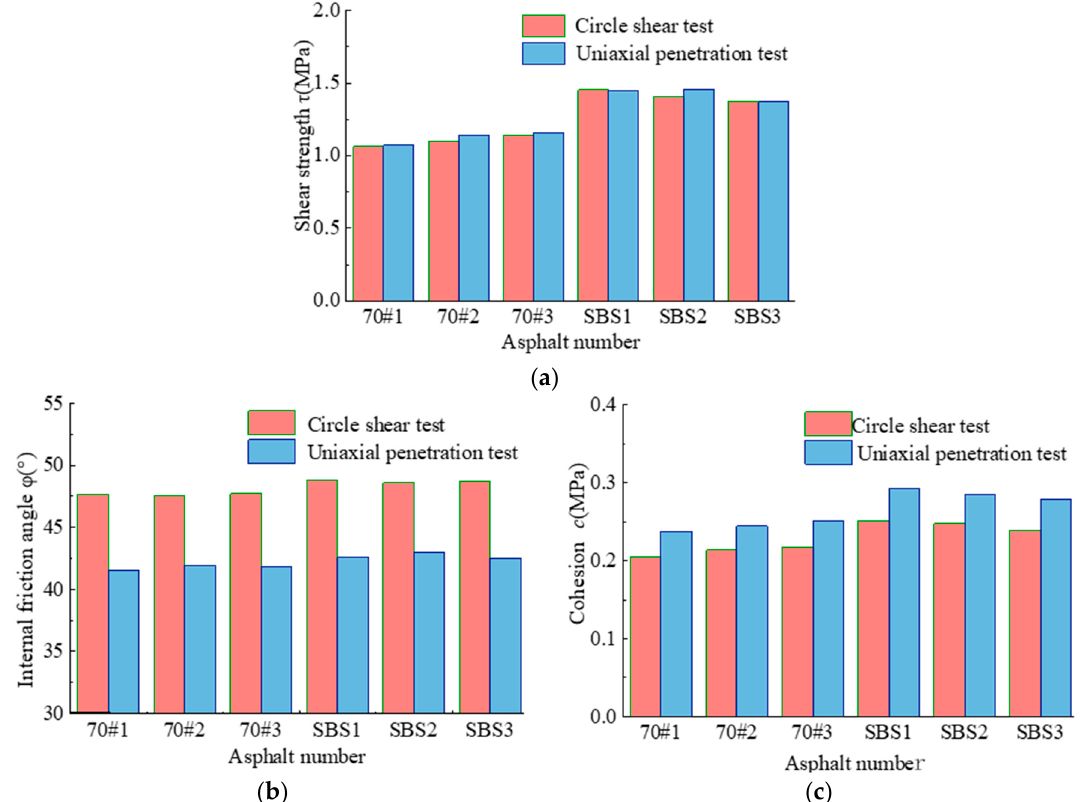
Figure 6. Shear strength, internal friction angle, and cohesion of different asphalts. ( a ) Shear strength; ( b ) Internal friction angle; ( c ) Cohesion.